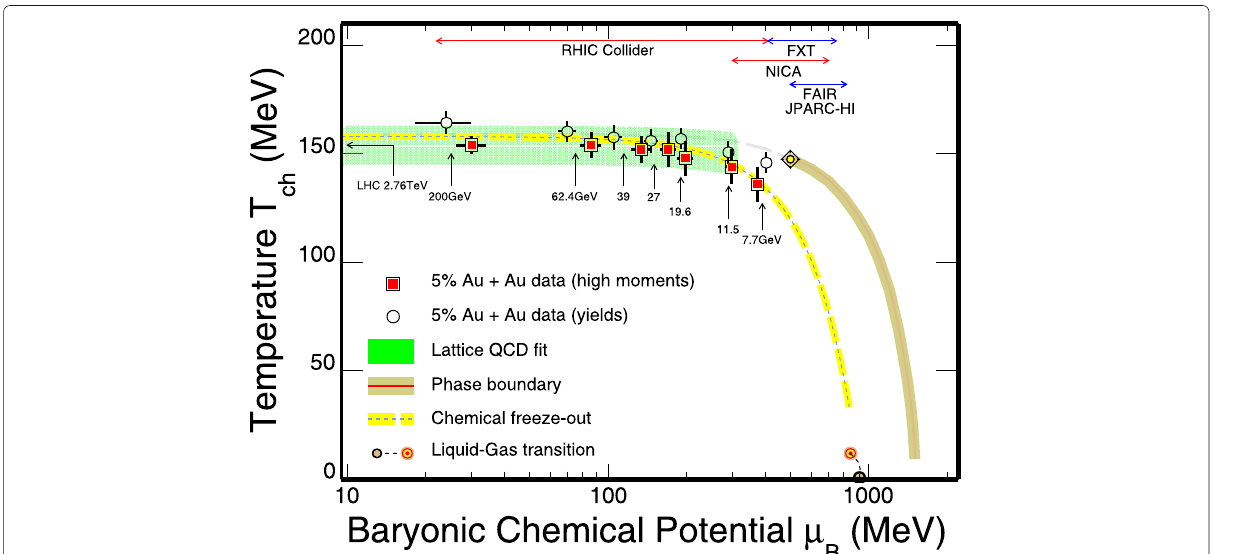
Fig. 2 Chemical freeze-out temperature T ch (μ B ) from the top 5% central Au+Au collisions at RHIC. Open-circles represent the parameters extracted from hadron yields [13], while the filled-squares are extracted from net-proton higher moments (up to third order) [14]. Representing the smooth crossover region is the lattice-QCD results shown by the green band. The empirical thermal fit results to global hadron yield data are shown as yellow line [15]. The coverage of the RHIC BES program, the STAR fixed target program (FXT), and future (FAIR, JPARC-HI, and NICA) experimental facilities are also indicated at the top of the figure. The liquid-gas transition region that features a second order critical point is shown by the red-circle, and a first-order transition line is shown by the black dashed line, which connects the critical point to the ground state of nuclear